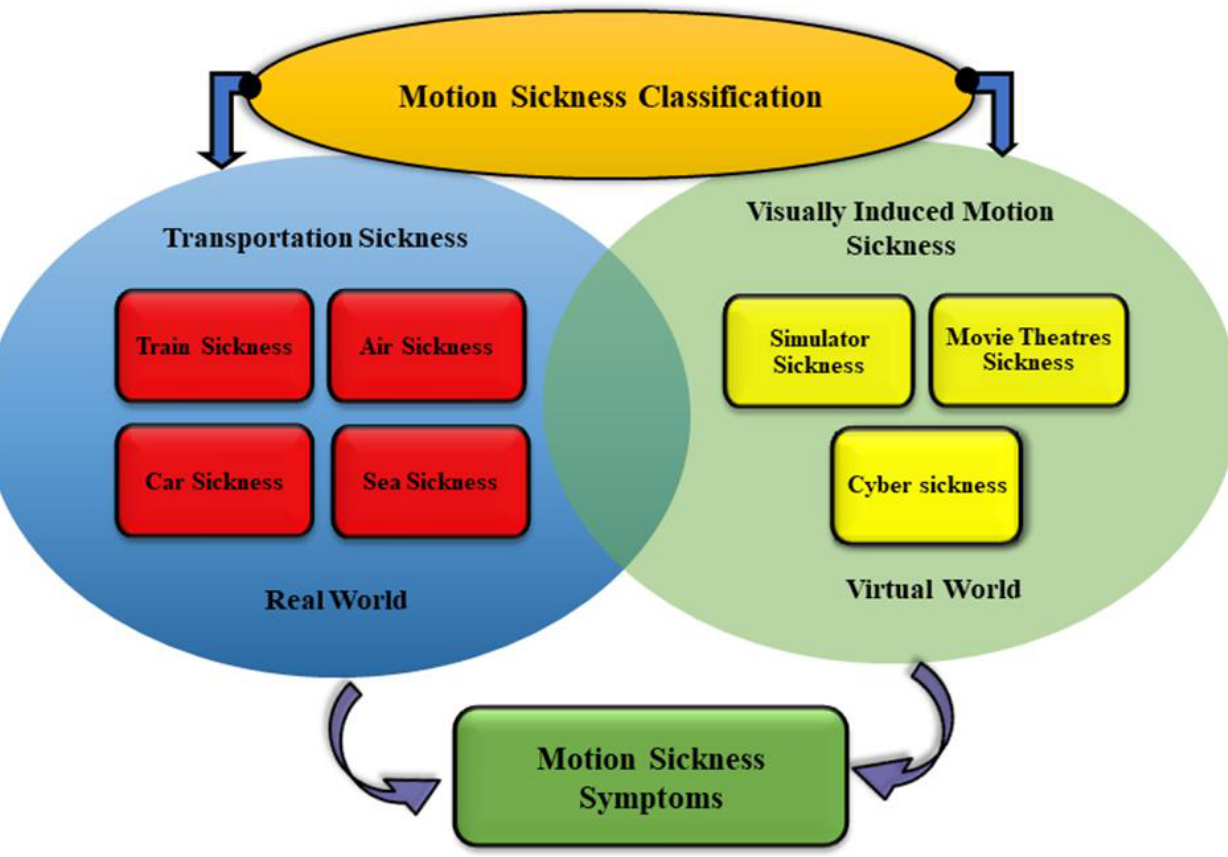
Figure 1. Classification of MS in both real and virtual environments. Airsickness, seasickness, carsickness, and trainsickness can occur on airplanes, ships, cars, and trains, respectively, while cyber- sickness, simulator sickness, and movie theater sickness can be caused using head-mounted displays, simulators, video games, and large 3D screens, respectively. Despite MS has been categorized into different subsections; however, the main symptoms are the same.